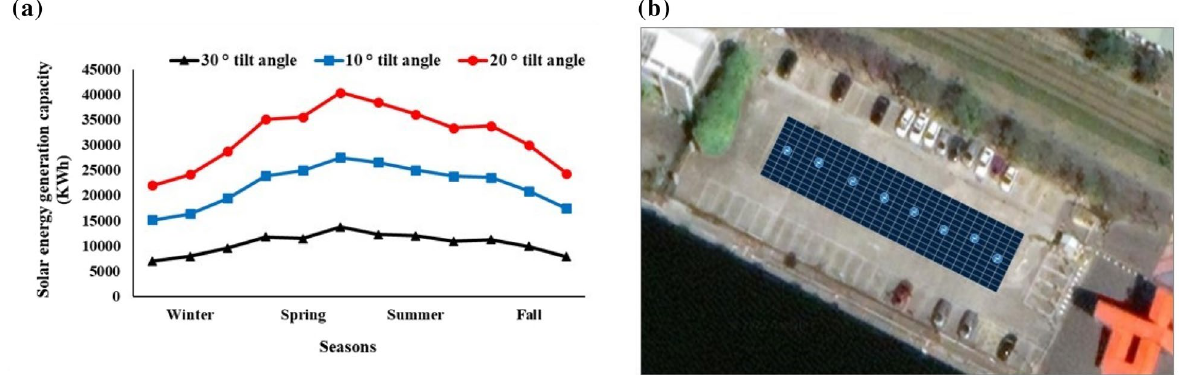
Figure 3. ( a ) Solar PV energy generation capacity in different seasons with various tilt angles; ( b ) Mono-pitch canopy without shading effects at optimum tilt of